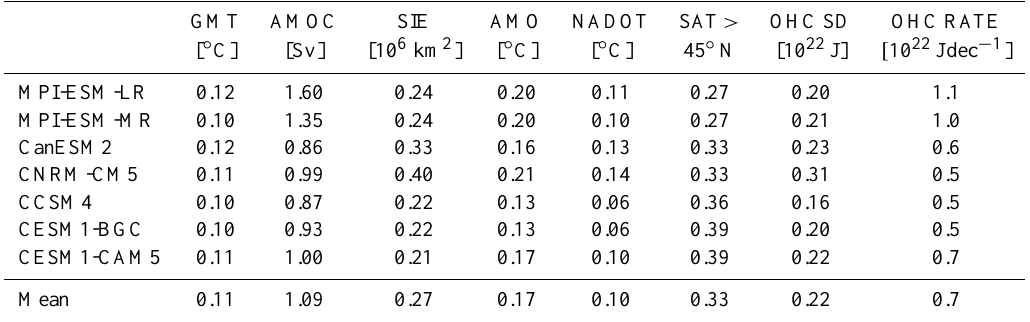
Fig. 2. Power spectral density of AMOC (blue), GMT (red) and SIE (grey). Light lines indicate the 95 % significance levels determined by a N=10000 ensemble of a red noise first order auto-regressive process fitted to each of the quantities. In this plot, all amplitudes are rescaled relative to the corresponding maximum of the 95 % significance level.